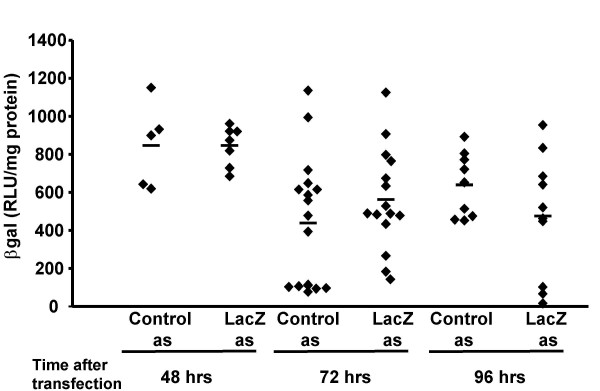
βgal protein after in vivo lung transfection of K18-lacZ with lacZ asODN. LacZ asODN (as4) or a control ODN was complexed to GL67 (160 μg/mouse), placed as a bolus (100 μl) onto the nostrils of anaesthetised mice and "sniffed" into the lung. Forty-eight to 96 hours after transfection the lungs were harvested β-gal protein expression was quantified. Each diamond represents an individual animal. The mean per group is indicated as a horizontal bar. * indicates p < 0.05 when compared to control group.